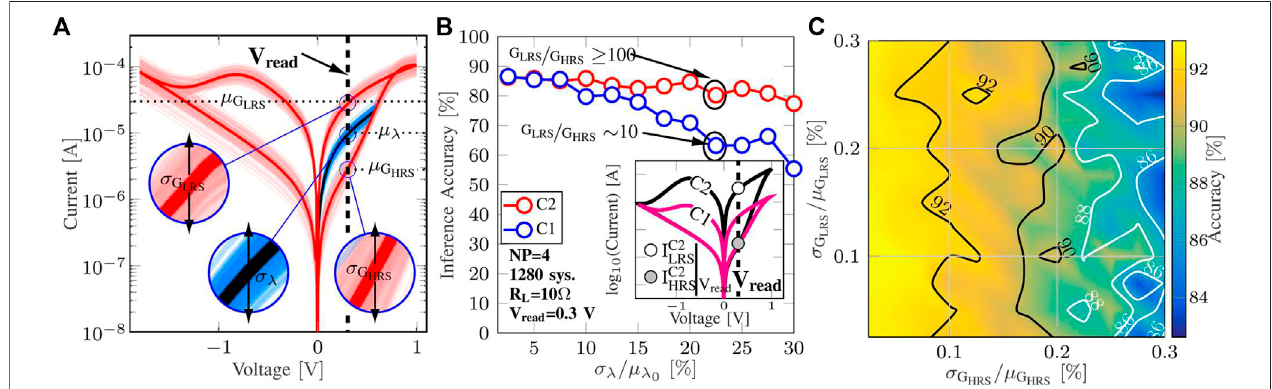
FIGURE10| Impactofthedevicevariabilityonthetestaccuracy. (A) Differentsourcesofvariabilityconsidered:R ON ,R OFF and λ . (B) Impactofthe λ variabilityonthe accuracy.Higherresistancewindowsimproverobustnessagainstvariability.Theinsetdepictstwodifferent I-V loopswithdifferentresistancewindows(10and100). (C) Inference accuracy is studied as function of the combined variability of R ON and R OFF for model plays C2 showing a higher dependence on R OFF .